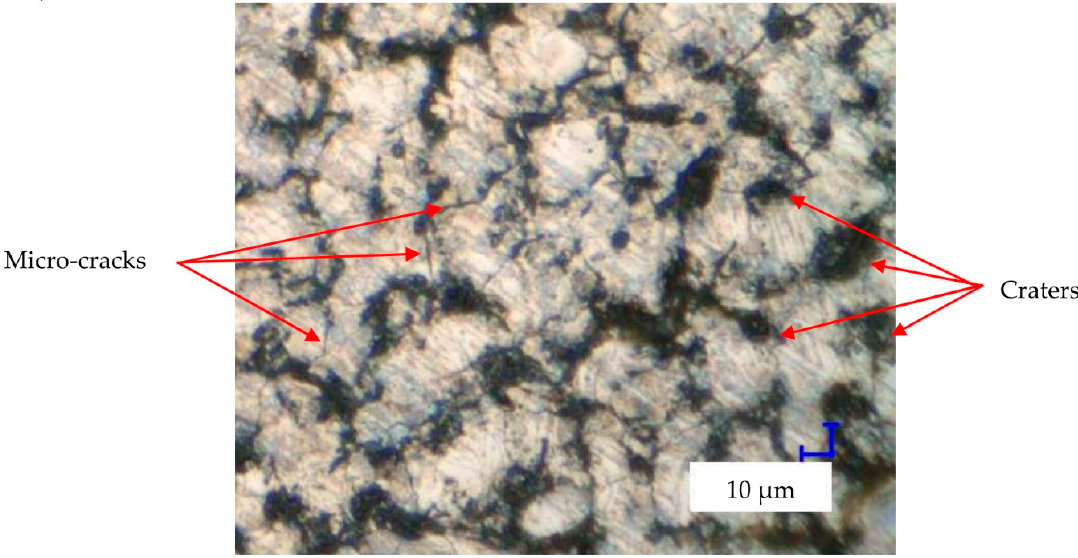
Figure 10. Structure of the surface after PMEMD with negative polarity RGO = 0.1% Uc = 25 V, I = 1 A, t on = 5 µs, t off = 5 µs.